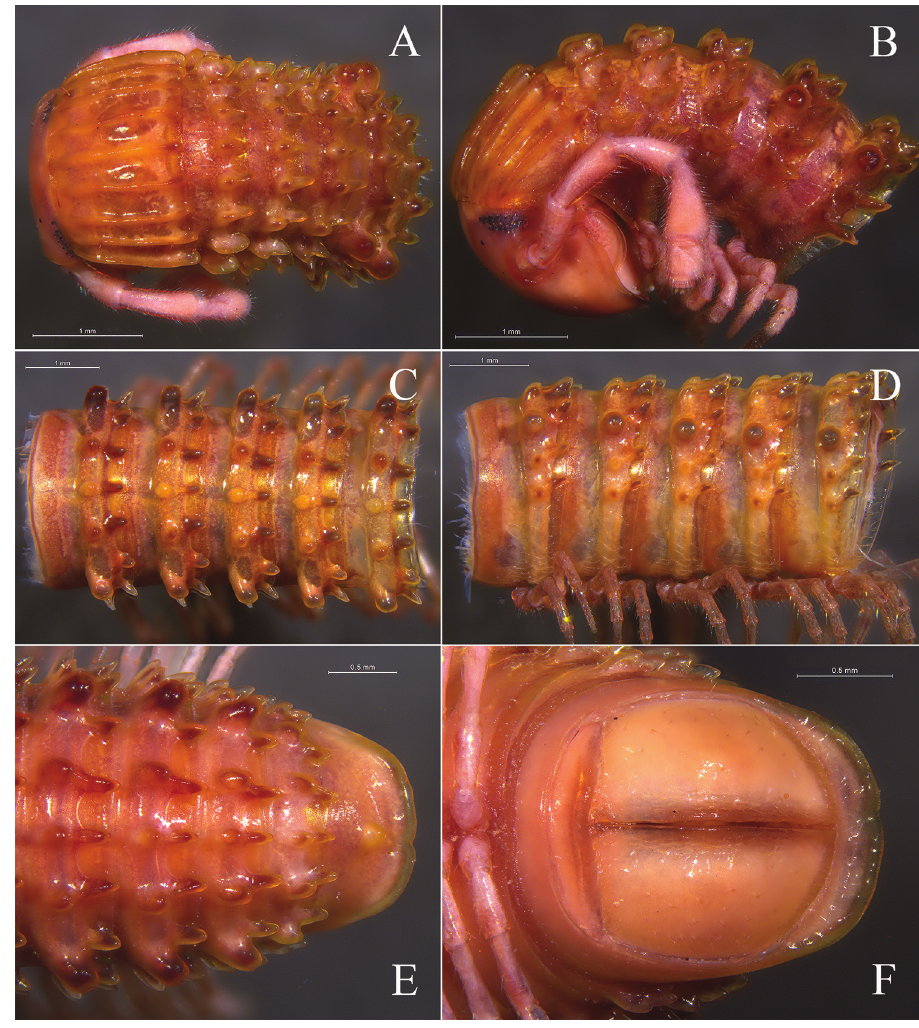
Figure 17. Glyphiulus impletus sp. n., holotype. A anterior part of body, dorsal view B same, lateral view C midbody segments, dorsal view D same, lateral view E posterior part of body, dorsal view F same, ventral